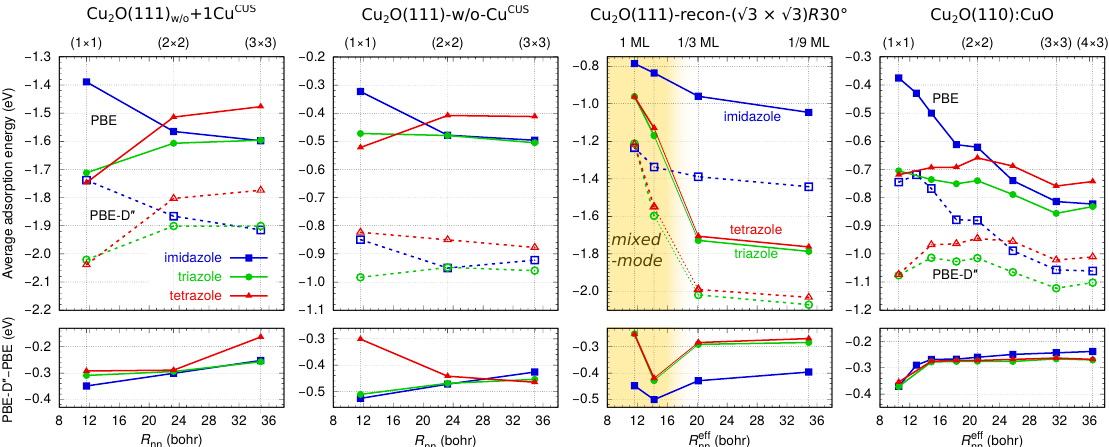
Figure 4. Top row: dependence of PBE (solid symbols and lines) and PBE-D (cid:48)(cid:48) (open symbols and dashed lines) calculated average adsorption energies on either the nearest-neighbor intermolecular distance ( R nn ) or the effective nearest-neighbor intermolecular distance ( R eff nn of Equation (18)) for imidazole, triazole, and tetrazole on considered Cu 2 O surfaces; note that the ordinate axes are different for each surface. Lines are drawn to guide the eye. Molecules preferentially bind to the following sites: Cu CUS on Cu 2 O(111) w/o +1Cu CUS , Cu CSA on Cu 2 O(111)-w/o-Cu CUS , Cu Ovac on √ √ Cu 2 O(111)-recon-( 3 × 3) R 30 ◦ , and Cu surf on Cu 2 O(110):CuO. Only the most stable configurations at each site are considered, which—apart from two exceptions—correspond to non-dissociative adsorption √ √ mode. The two exceptions are triazole and tetrazole at Cu Ovac sites on Cu 2 O(111)-recon-( 3 × 3) R 30 ◦ , for which dissociative adsorption is the stablest (cf. Figure 3c). However, when all the Cu Ovac sites √ √ are occupied on Cu 2 O(111)-recon-( 3 × 3) R 30 ◦ , which happens at a relative coverage of 1/3 ML, the molecules start to adsorb non-dissociatively; this implies a mixed-mode adsorption for coverages larger than 1/3 ML. The transition from dissociative to mixed-mode adsorption is seen by the large upward “jump” in adsorption energy as going 1/3 to 2/3 ML coverage; coverages at which the mixed-mode adsorption takes place are indicated by a yellowish band. Bottom row: the difference between PBE-D (cid:48)(cid:48) and PBE adsorption